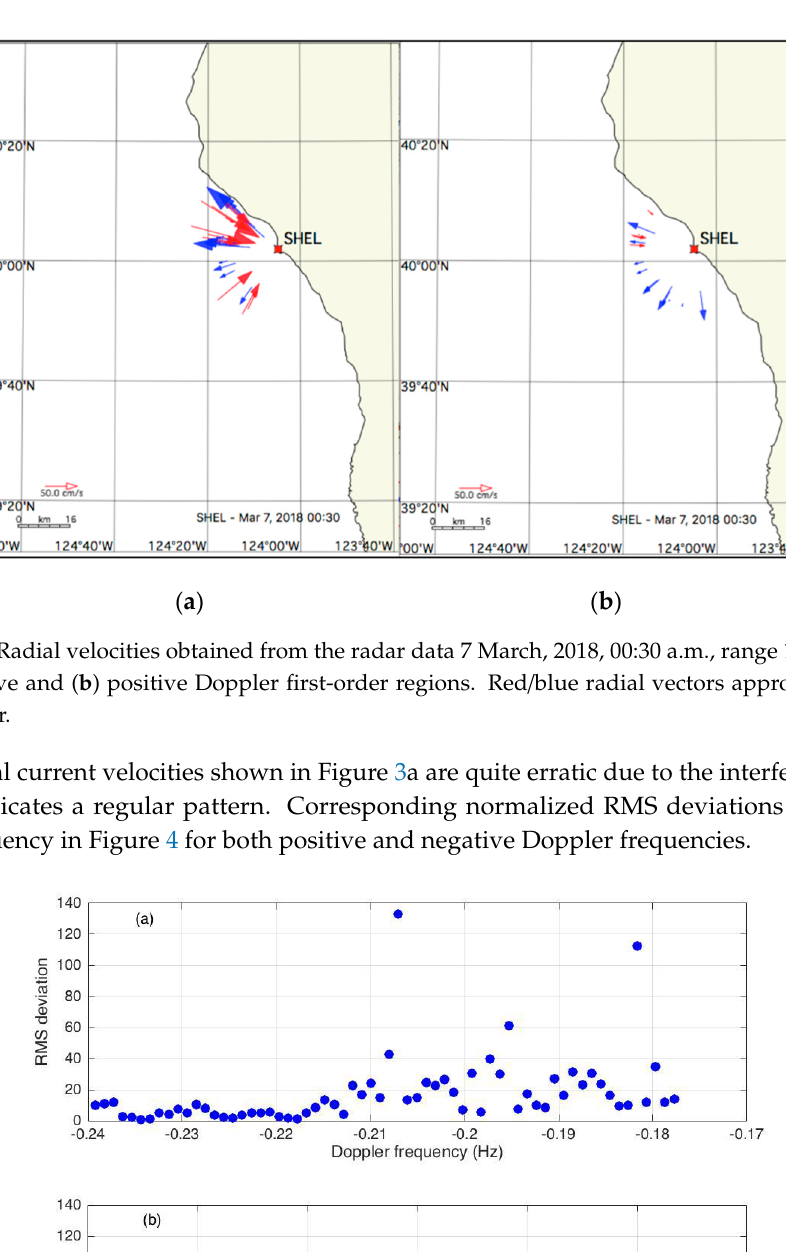
Figure 4. RMS deviations plotted vs. Doppler frequency for Shelter Cove on 7 March, 2018, 00:30 a.m., range 18 km ( a ) negative ( b ) positive Doppler frequencies.